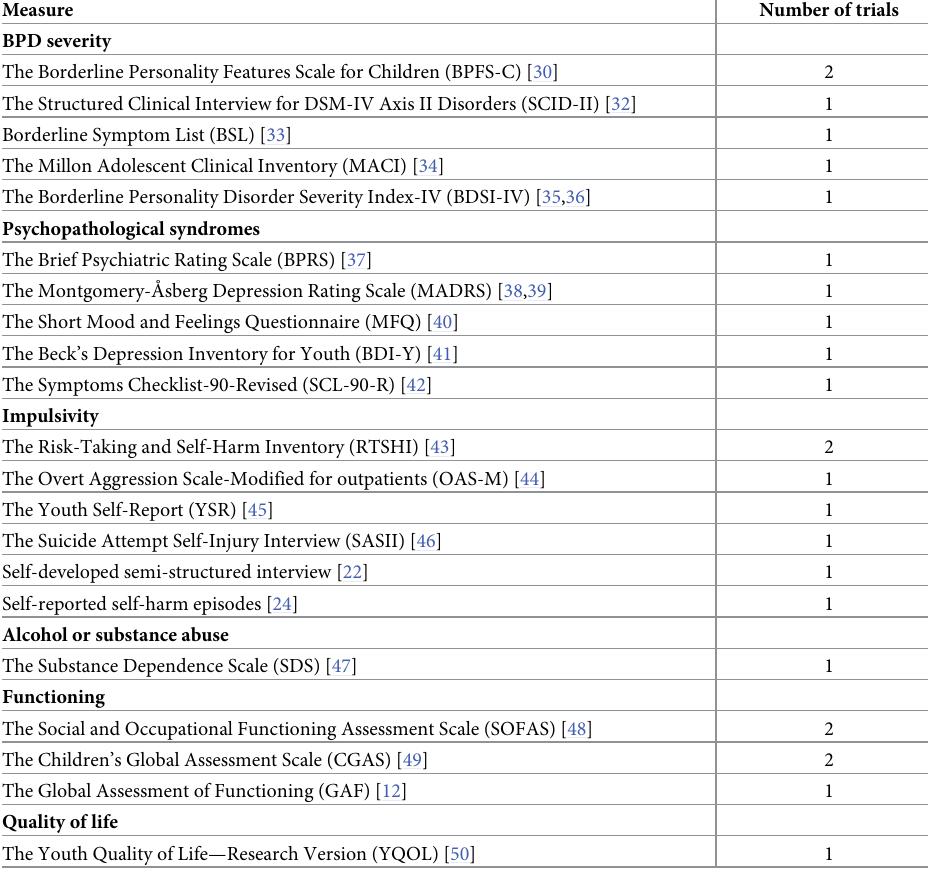
Table 2. Overview of the measures used in this review to assess primary and secondary outcomes. Measure Number of trials BPD severity The Borderline Personality Features Scale for Children (BPFS-C) [30] 2 The Structured Clinical Interview for DSM-IV Axis II Disorders (SCID-II) [32] Borderline Symptom List (BSL) [33] The Millon Adolescent Clinical Inventory (MACI)